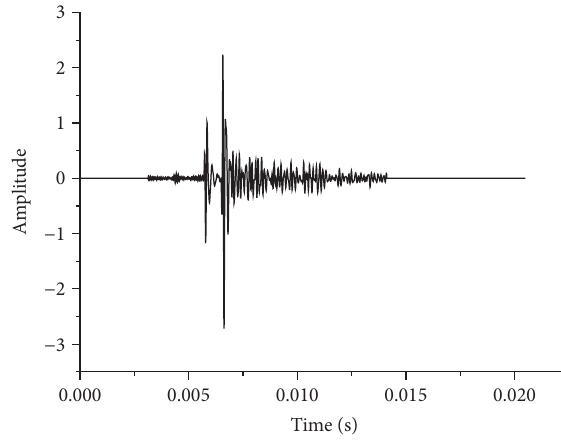
Figure 5: Filtered time domain of